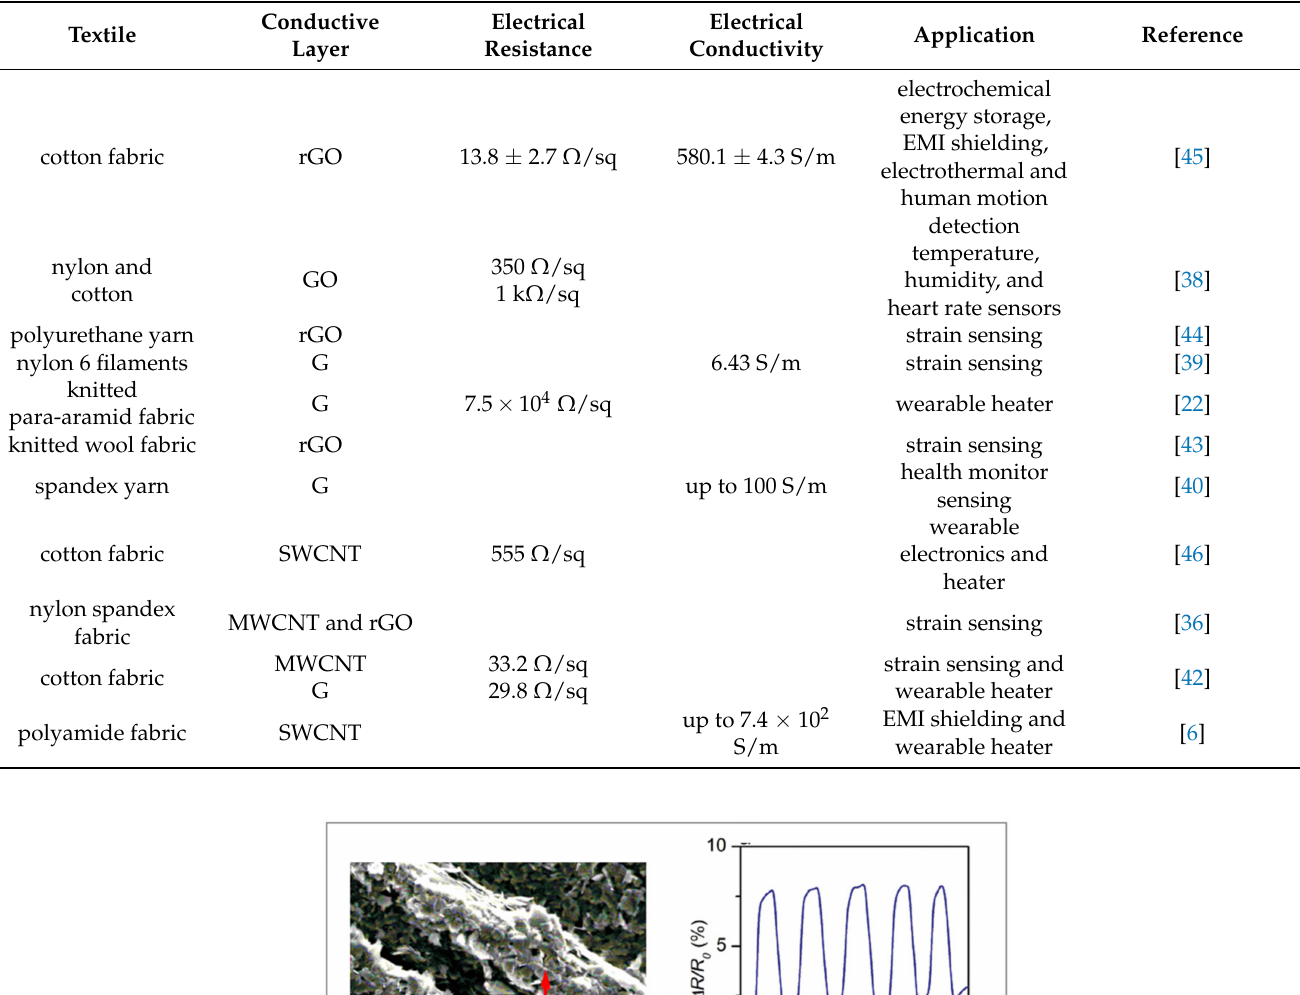
Table 3. Dip-coating of carbon-based materials on textiles for diverse applications.